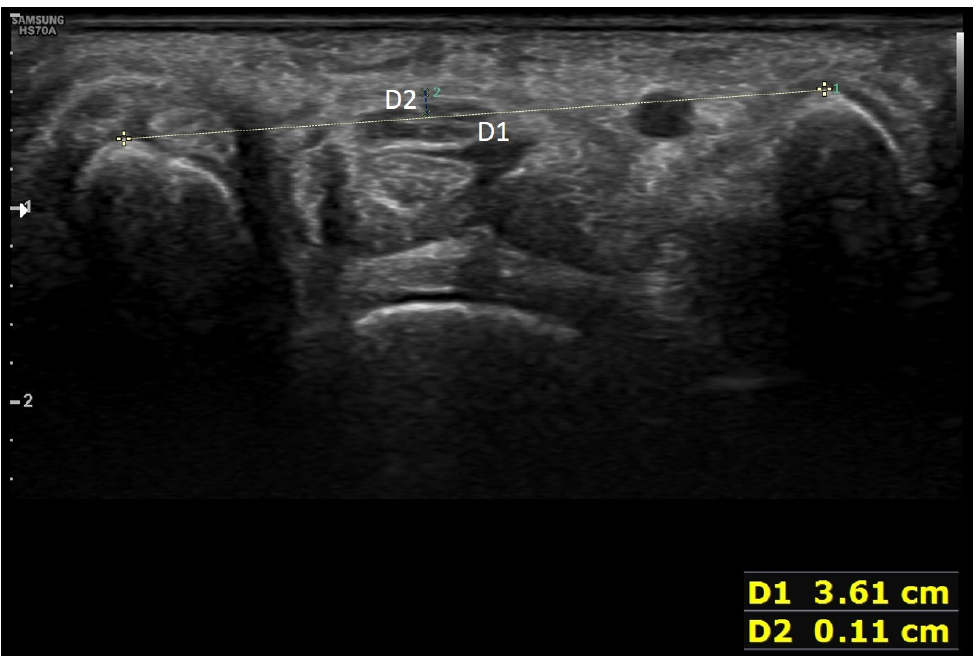
Figure 2. Diagnostic criteria for carpal tunnel syndrome by ultrasound relevant to palmar bowing of the flexor retinaculum. The yellow dot line of D1 shows a line connecting the top of the pisiform and the scaphoid bone. D2 is the distance from D1 to the transverse carpal